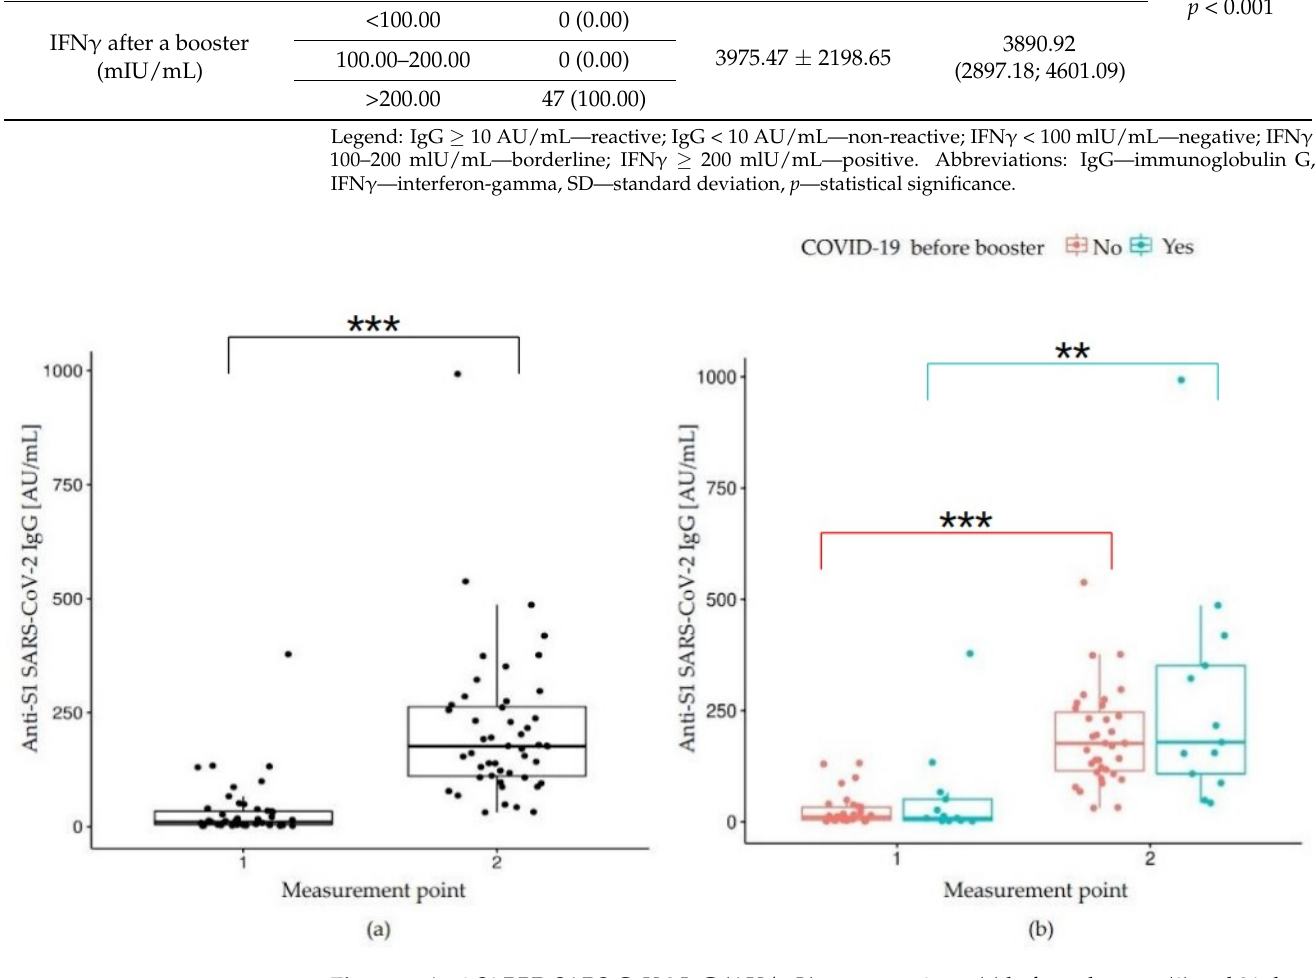
Figure 2. Anti-S1 RBD SARS-CoV-2 IgG (AU/mL) concentrations: ( a ) before a booster (1) and 21 days after (2), p < 0.001; ( b ) before a booster (1) and 21 days after (2) depending on the COVID-19 status before the study start. If a p -value is less than 0.01, it is flagged with 2 stars (**). If a p -value is less than 0.001, it is flagged with three stars (***).